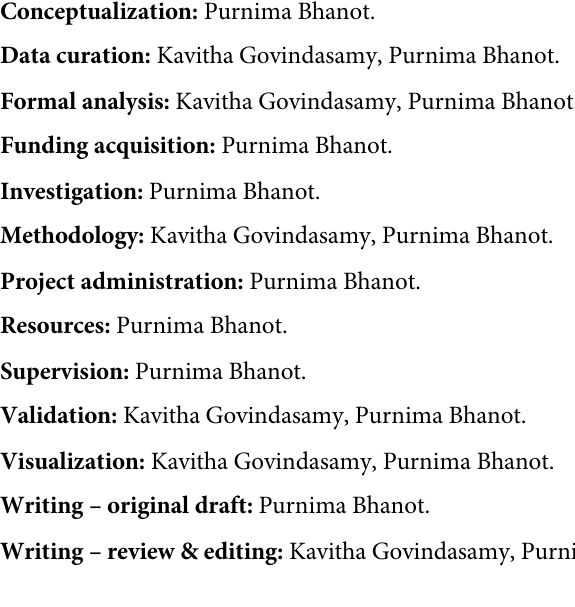
S7 Fig. Model of CDPK functions in pre-erythrocytic stages. CDPK family members play a critical role during several steps of hepatocyte infection. Sporozoite motility and